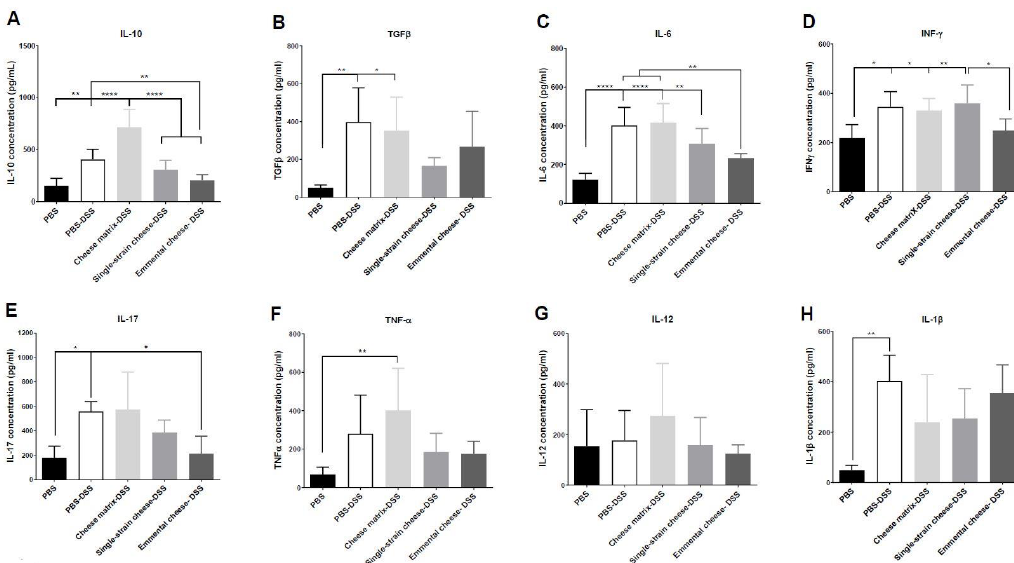
Figure 8. Impact of cheese matrix, single-strain cheese and Emmental cheese on colonic secretion of cytokines during DSS-induced colitis. Cytokines concentration of ( A ) IL-10, ( B ) TGFβ, ( C ) IL-6, ( D ) ( D ) IFN γ , ( E ) IL-17, ( F ) TNF α , ( G ) IL-12 and ( H ) IL-1 β were quantified by ELISA. Data IFNγ, ( E ) IL-17, ( F ) TNFα, ( G ) IL-12 and ( H ) IL-1β were quantified by ELISA. Data represent the mean ± SD of 6 mice per group. Groups were as follows. PBS: healthy group gavaged using PBS buffer as a sham. PBS-DSS: DSS-treated-colitis control group gavaged using PBS buffer as a sham. Cheese matrix- DSS: DSS-treated group gavaged using a germ-free dairy matrix. Single-strain cheese-DSS: DSS- treated group gavaged using an experimental single-strain cheese containing P. freudenreichii CIRM- BIA 129 as a sole bacterium. Emmental-DSS: DSS-treated group gavaged using an industrial Emmental cheese produced using P. freudenreichii CIRM-BIA 129 as a ripening starter. Multiple comparisons were performed, * p < 0.05, * p < 0.05 ** p < 0.01, *** p < 0.001 **** p < 0.0001.